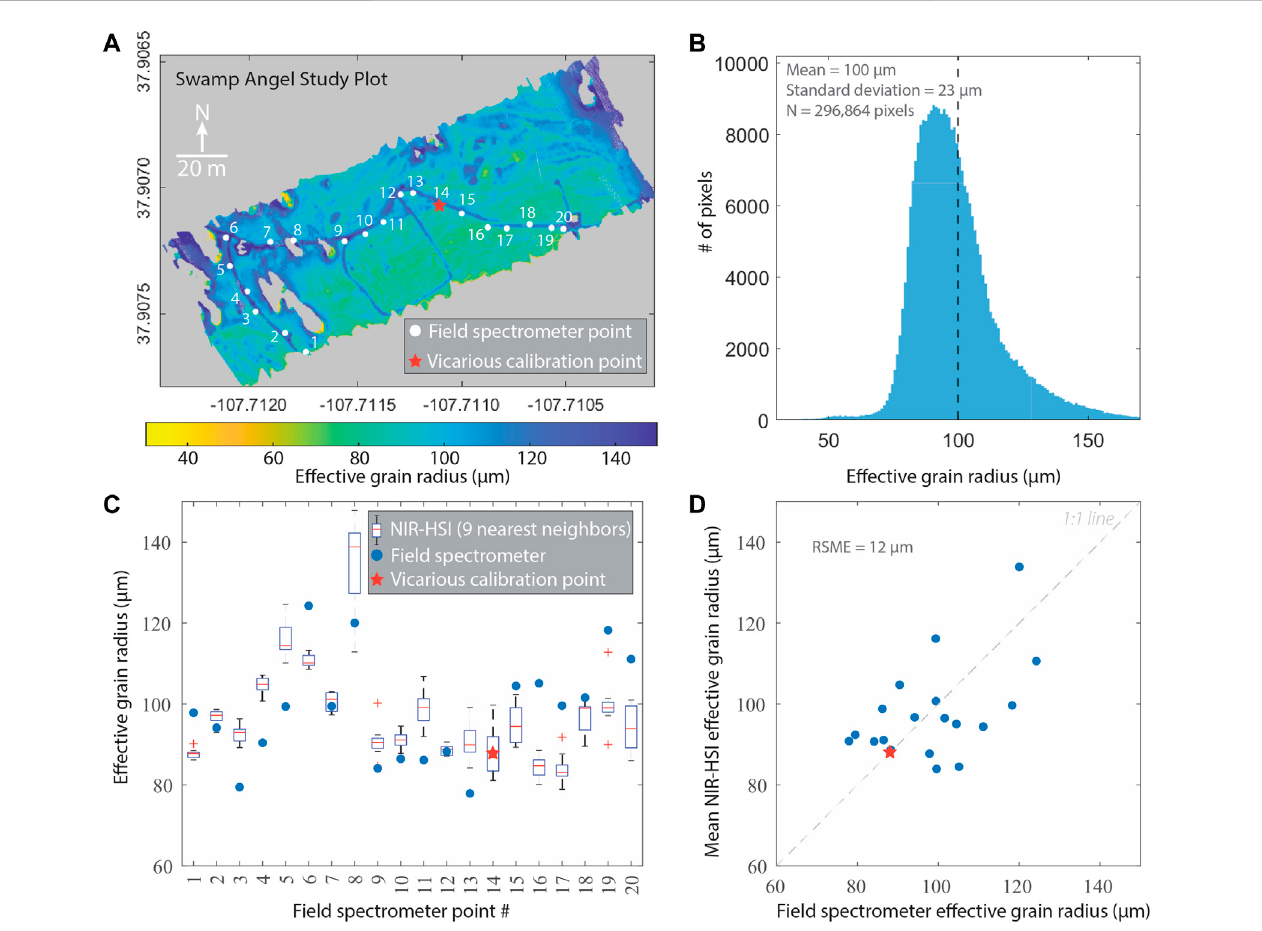
FIGURE 9 Vicariously calibrated UAV-HSIgrainsize retrievalscomparedtothe in situ fi eldspectrometer pointmeasurements. (A) Effective grainsize map retrieved fromUAV-HSIandthelocationofthe fi eldspectrometerpoints. (B) HistogramoftheUAV-HSIeffectivegrainsizesacrossthemapin (A) . (C) Theeffectivegrain size for each fi eld spectrometer point measurement (blue circles) compared against the box plot distribution of UAV-HSI grain sizes in the 9 neighboring pixels. (D) One-to-one plot comparing the average (mean) grain size from 9 neighboring pixels to that from the fi eld spectrometer.